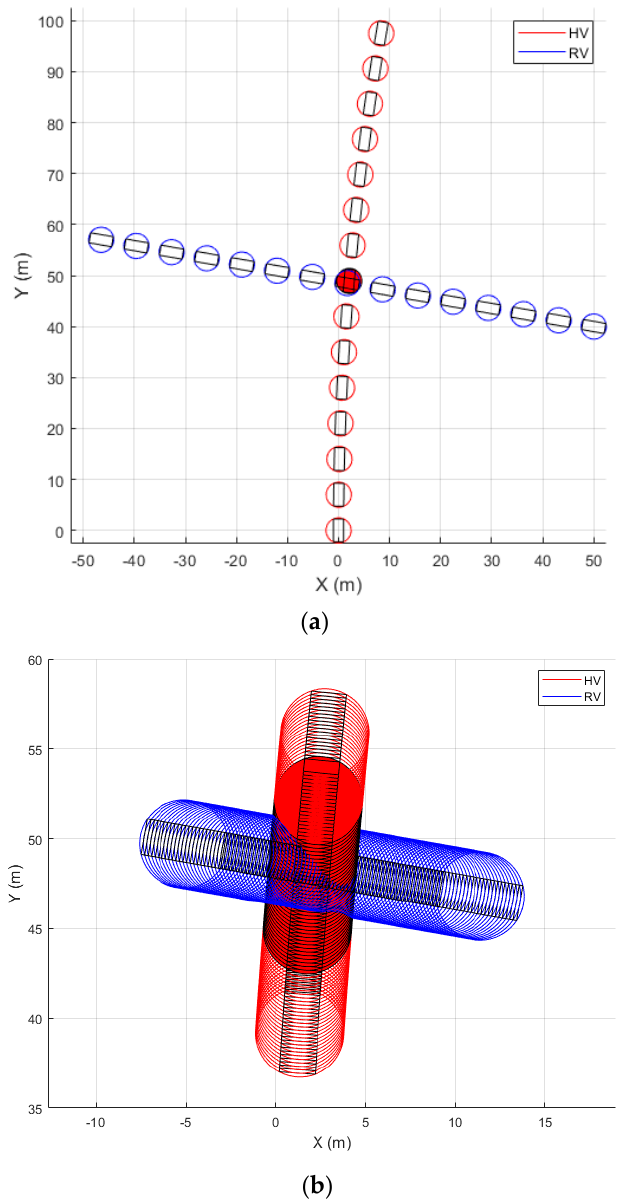
Figure 4. Collision event detection (circles filled in red) and time-to-collision (TTC) estimation using the predicted future trajectories of the host vehicle (HV) and the remote vehicle (RV). ( a ) Preliminary risk assessment step for collision detection; ( b ) detailed risk assessment step for TTC estimation. Table 8. Conditions for the vehicle collision warning